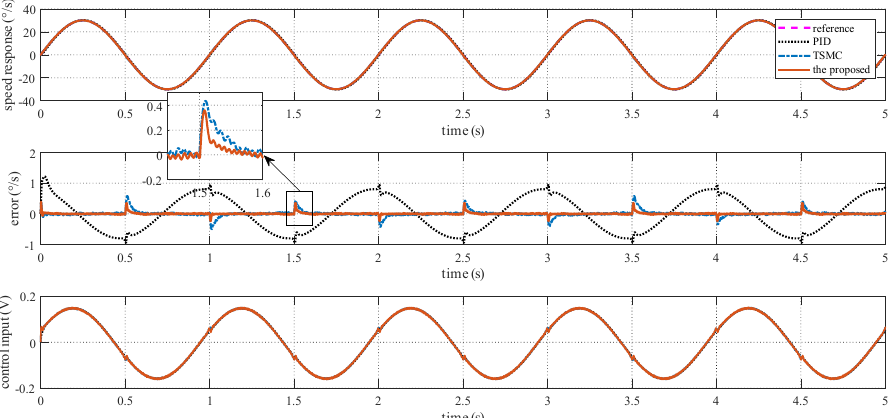
Figure 5. Simulation response curves to a sinusoidal reference signal with 30 ◦ /s amplitude and 1 Hz frequency.